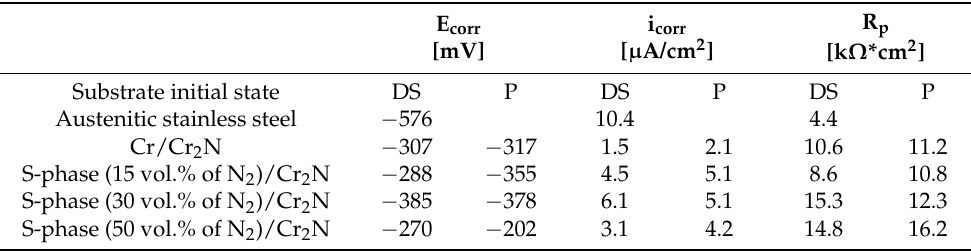
Table 2. Corrosion potential (E corr ), corrosion current density (i corr ) and polarization resistance (R p ) for investigated coatings.